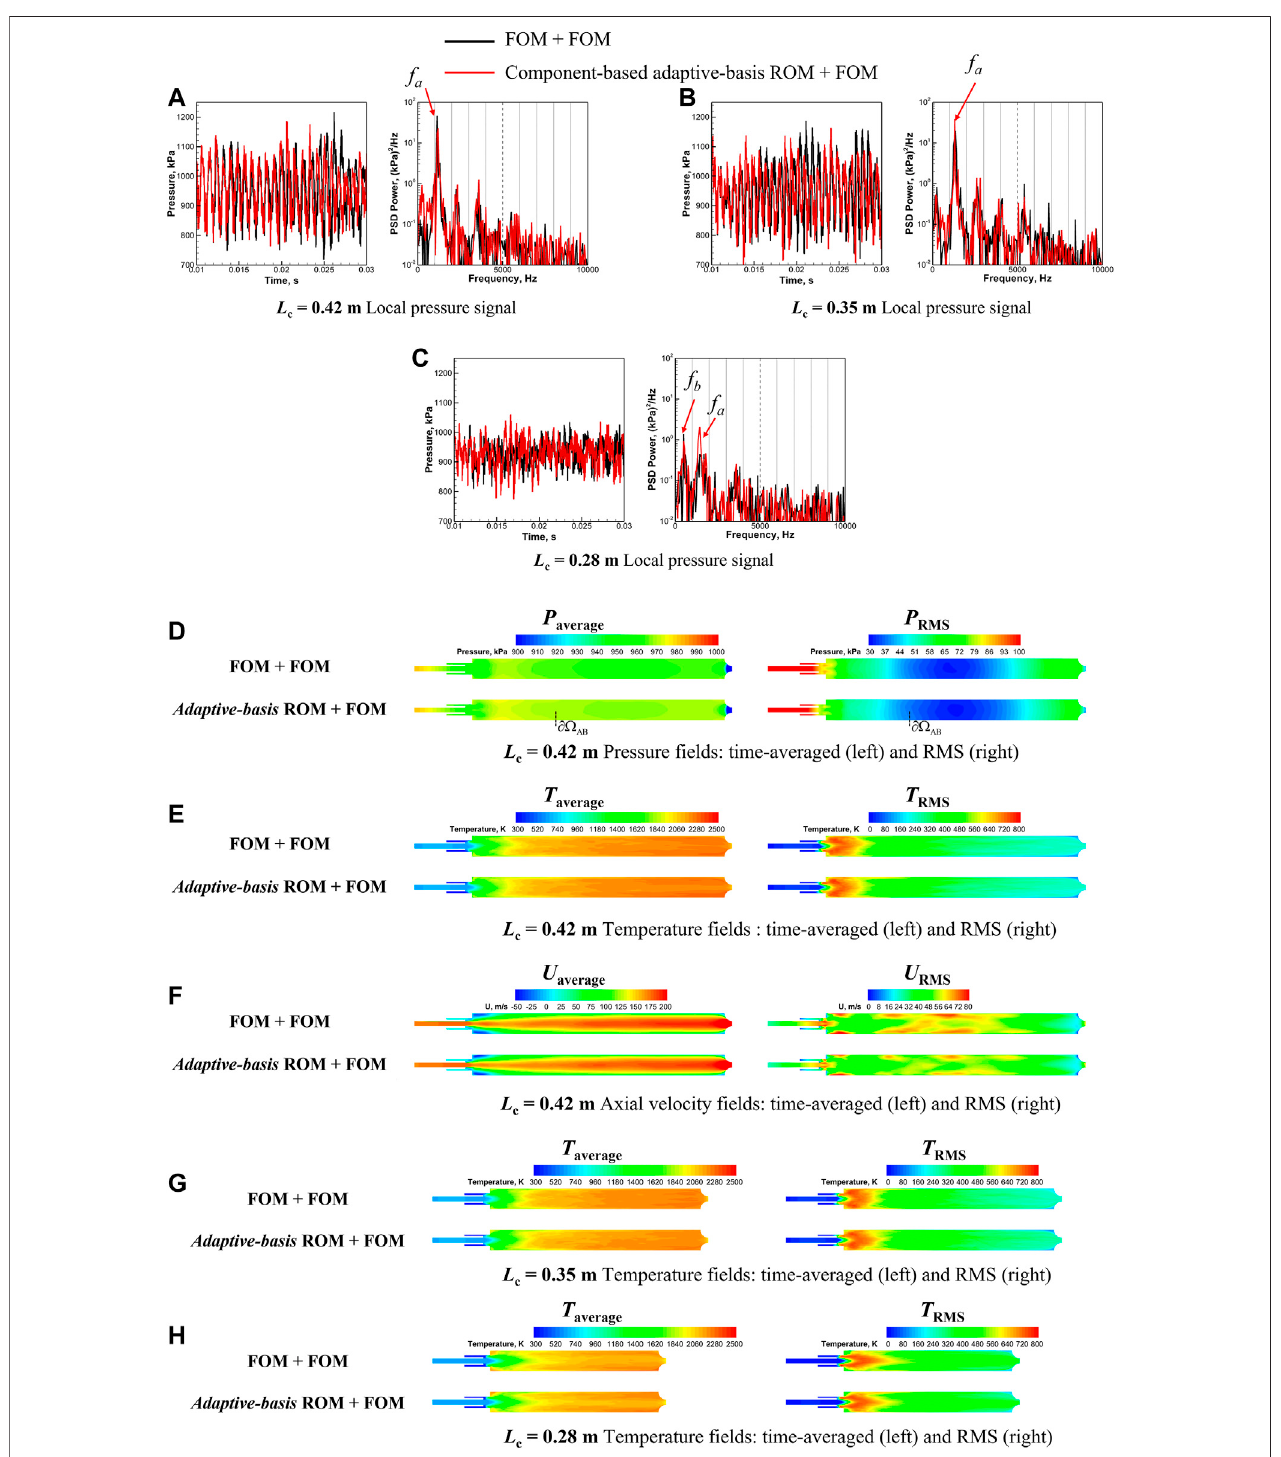
FIGURE7| Comparisonsof (A – C) pressuresignalsmeasuredat x =0in Figure4 ,time-averaged(left)androot-mean-square(right) (D) pressure, (E) temperature, and (F) axial velocity fi elds for L c = 0.42 m, and time-averaged (left) and root-mean-square (right) temperature fi elds for L c = (G) 0.35 and (H) 0.28 m with component- based adaptive-basis ROM and FOM used for the upstream injector element ( Ω A ) for the single-injector combustor.